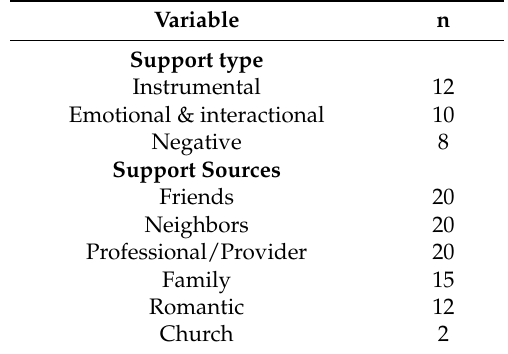
Table 3. Frequency of residents discussing different types and sources of support in qualitative interviews (N =